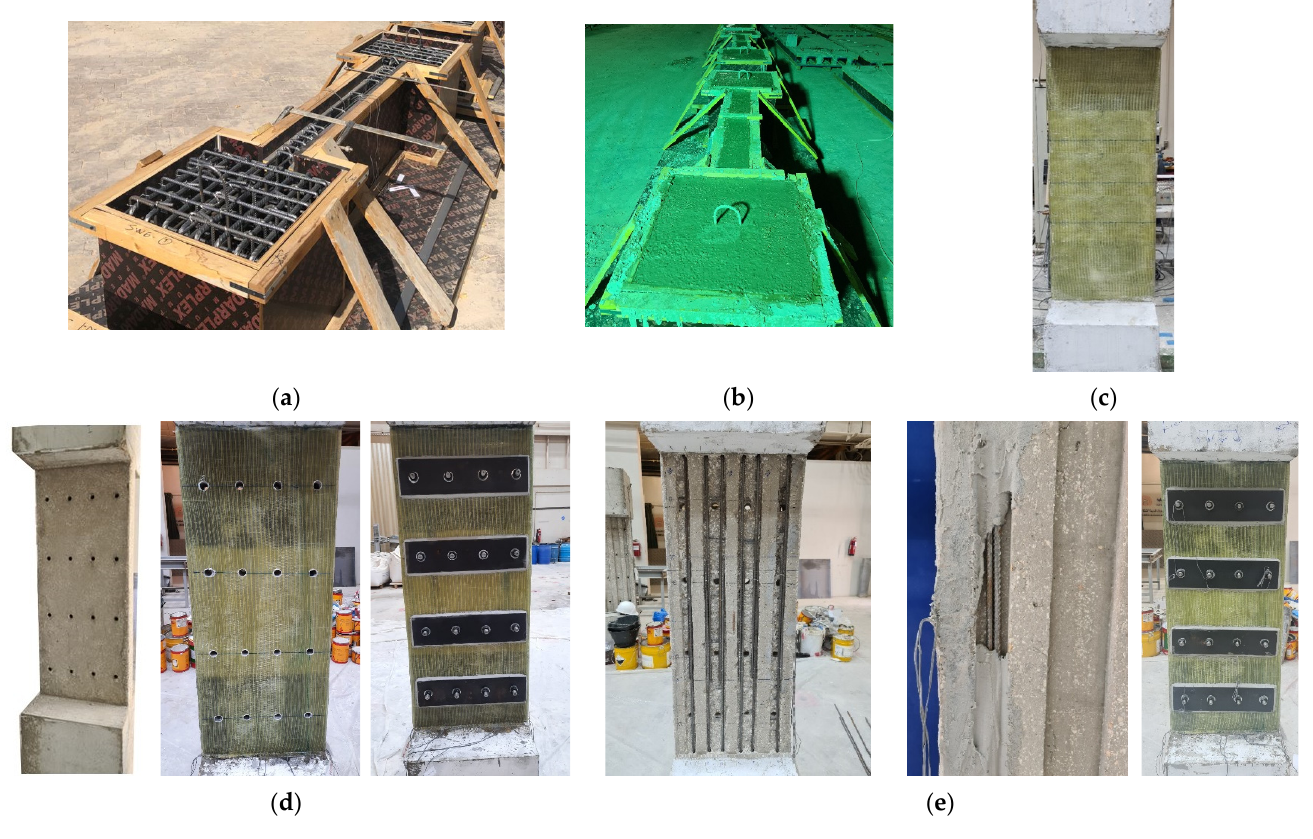
Figure 6. Preparation of columns: ( a ) reinforcement cage in the formwork before concrete casting; ( b ) column specimens after concrete casting; ( c ) strengthened specimen S1 after GFRP wrapping; ( d ) strengthening of specimen S2 using GFRP sheets combined with bolted steel plates; ( e ) strength- ening of specimen S3 using GFRP sheets combined with bolted steel plates and connected NSM bars.